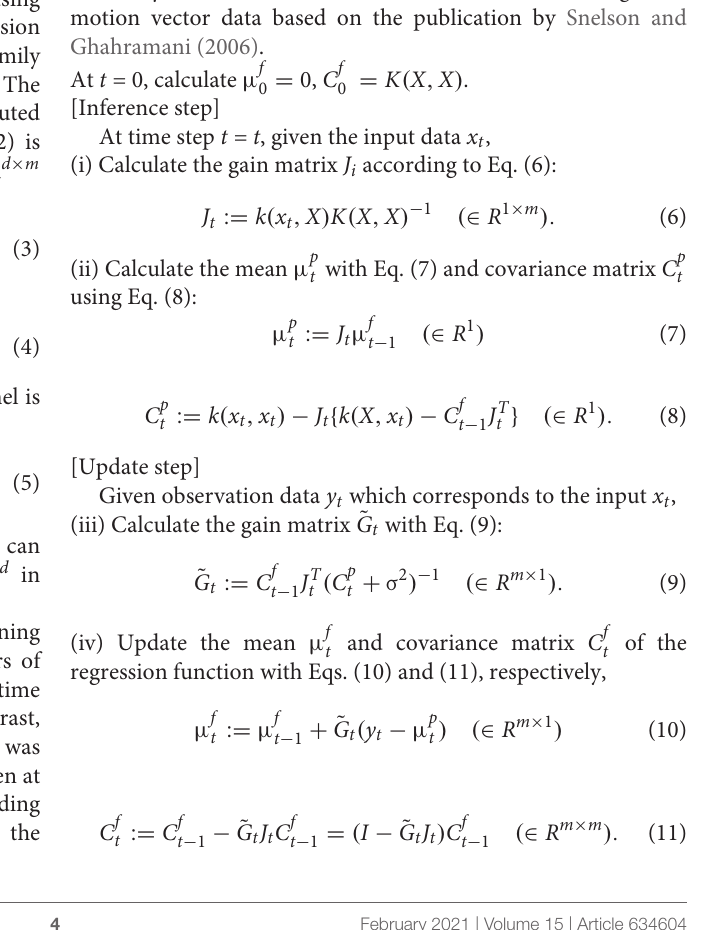
A recursive Gaussian process regression model (Huber, 2014), one of the Bayesian, non-linear, non-parametric regression models, was used in the present study to model the process of sequential learning for various motion patterns [see Eq. (2)] and to predict the subsequent motion in the presence of